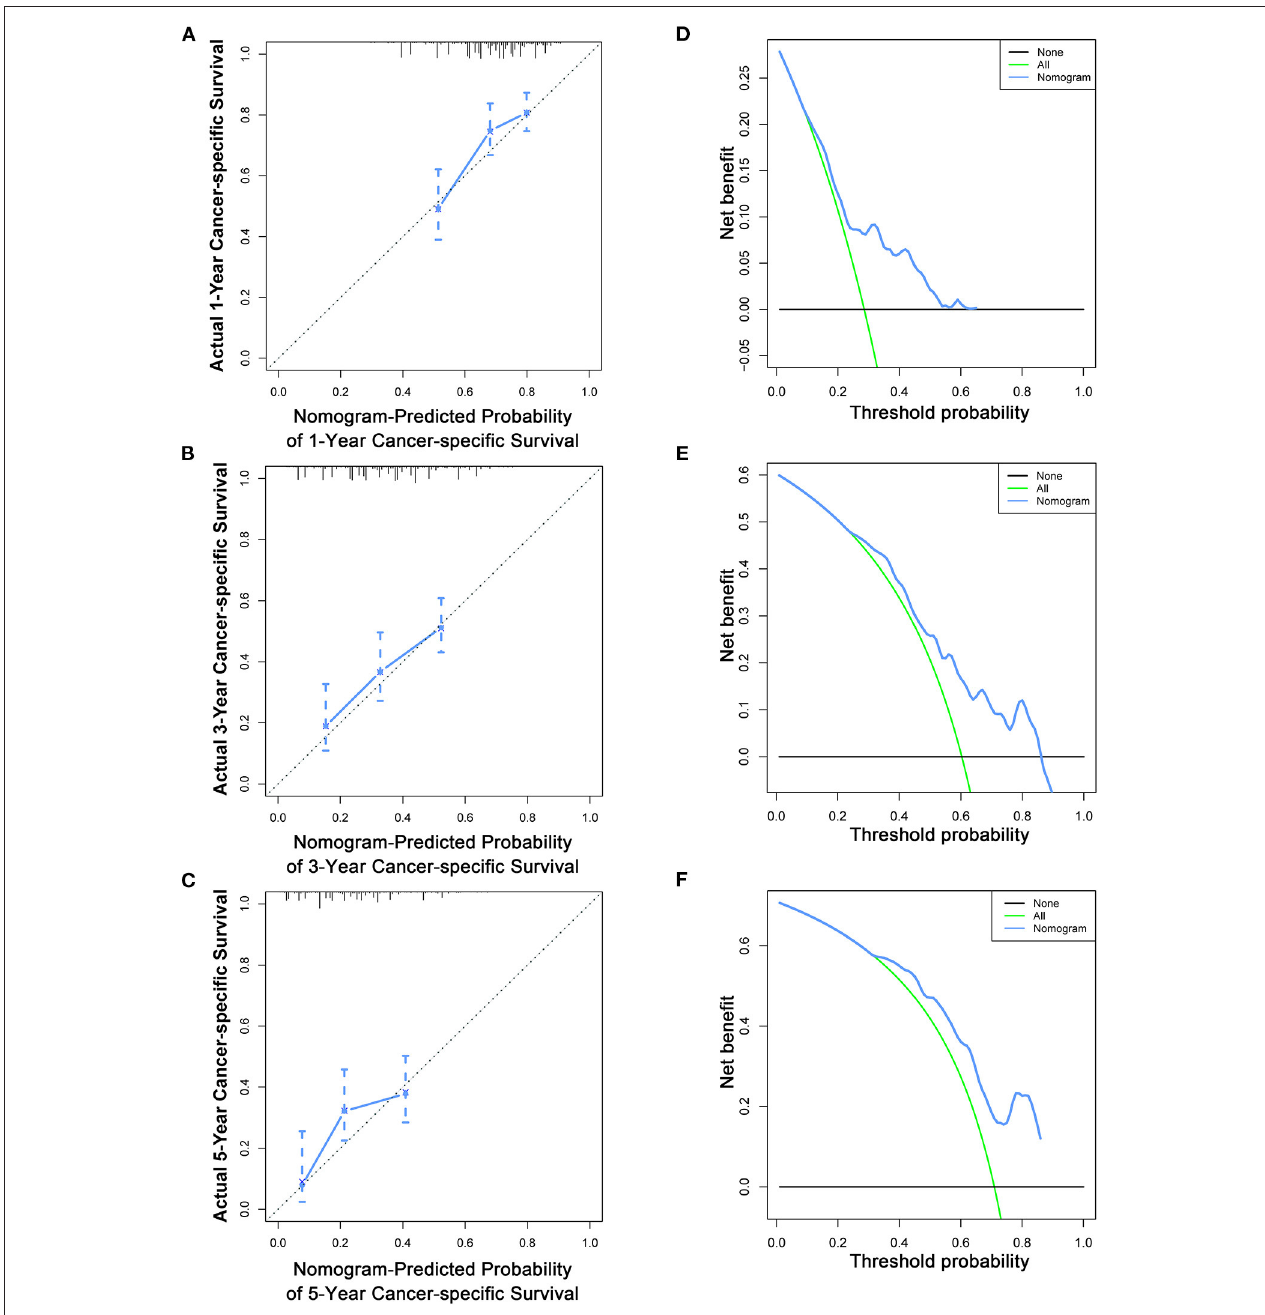
FIGURE 8 | Calibration curves (A–C) and DCA (D–F) of the nomogram for predicting patients’ CSS at 1, 3, and 5 years in the validation